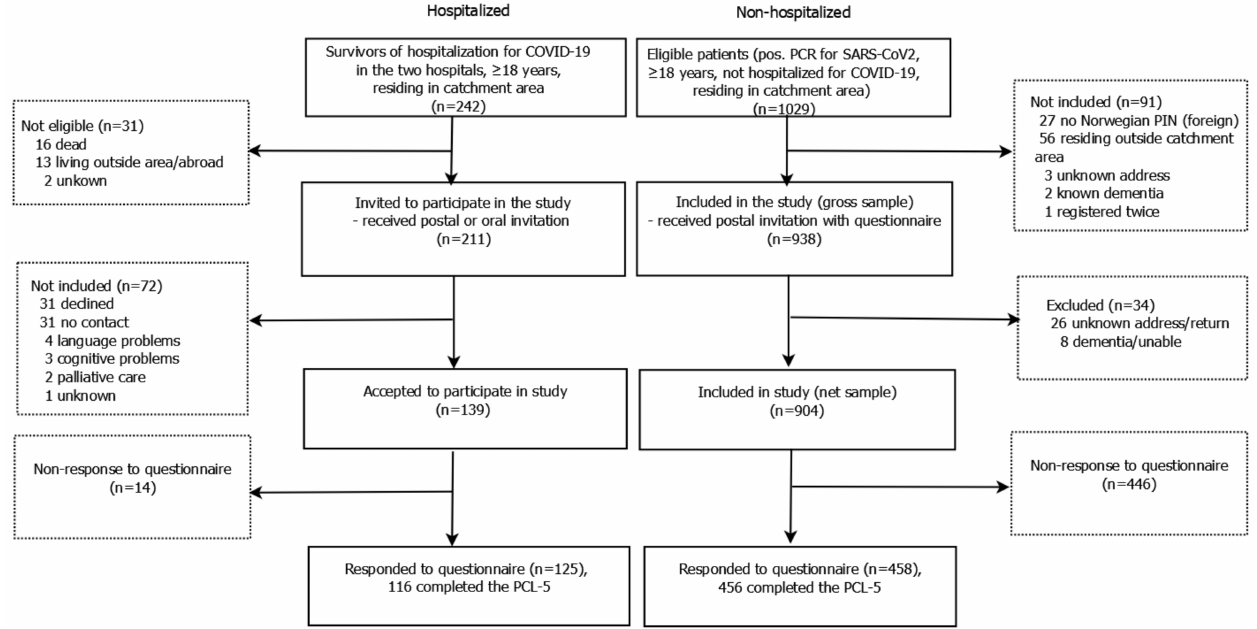
Figure 1. Flow chart of studies. PCL-5, post-traumatic stress disorder symptom checklist for DSM-5 (PCL-5); PCR, polymerase chain reaction; SARS-CoV-2, severe acute respiratory syndrome